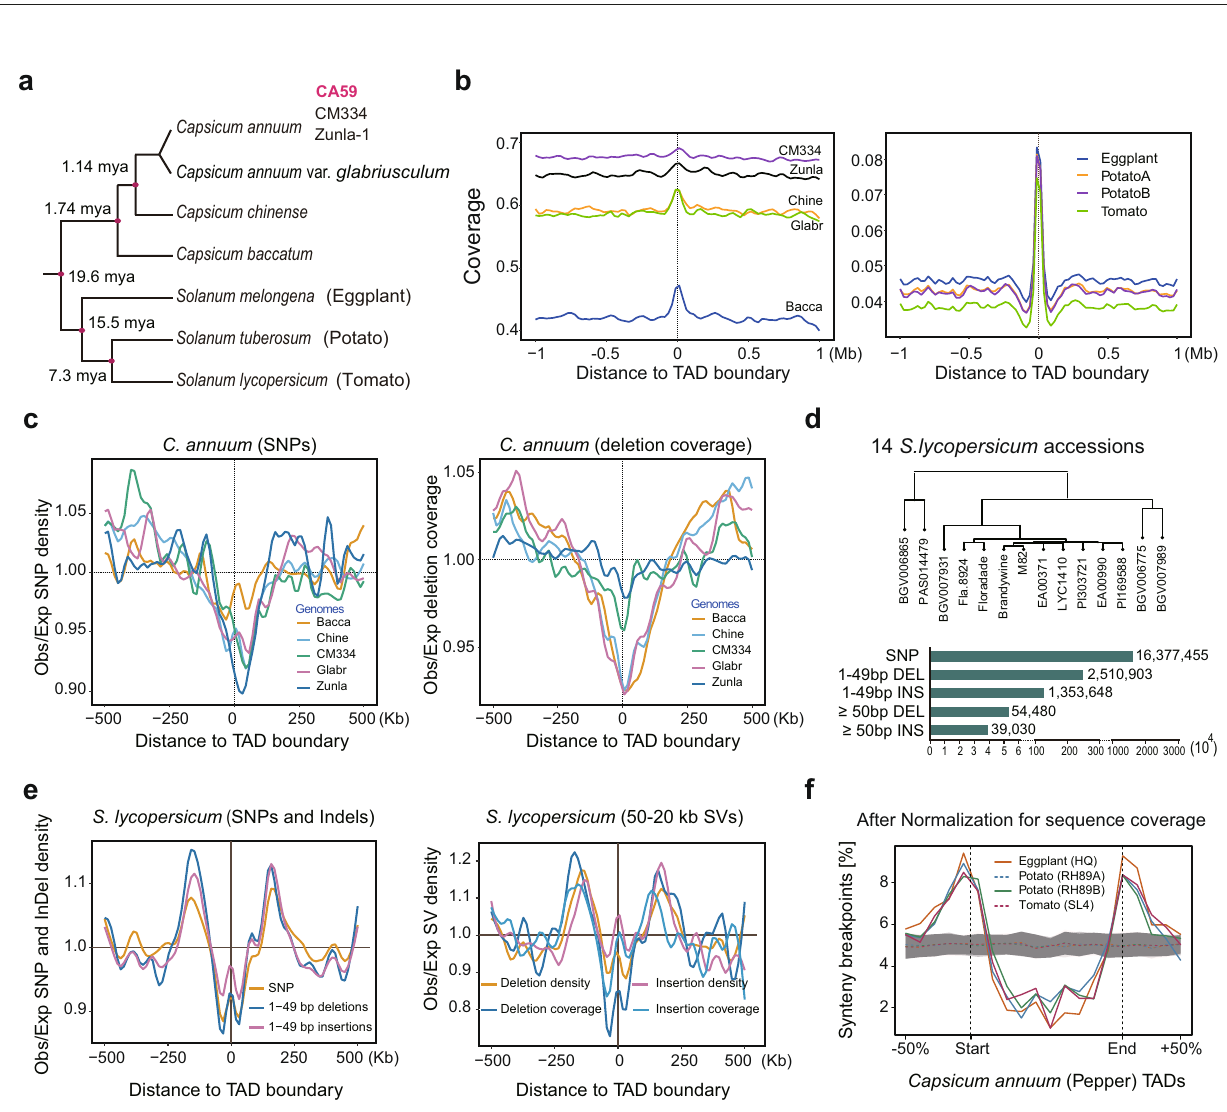
Fig. 5 Chromatin folding domains are frequently demarcated by gene-to-gene loops. a Chromatin loops identi fi ed across tissues with Hi-C maps at multiple resolutions (e.g., 10, 15, 20, and 25 kb) by hicDetectLoops. Boxplot shows the median with (the fi rst and third) quartiles. Red dots indicate the mean values of loop size. b Numbers of tissue-speci fi c and shared loops. For each tissue, a shared loop was identi fi ed if it was present in any other tissues. A merged loop set was constructed by removing the redundant calls across all four tissues. c Example showing a genomic region (Chr09: 68,000,000 – 72,000,000) where chromatin loops demarcate TAD-like domains. Subcompartments and TADs identi fi ed at both 10-kb and 40-kb resolution for this region were shown above and right. Loops were shown as red dots in the Hi-C contact maps at 40 kb resolution (leaf). d Enrichment of contact frequency was observed at the corners of TAD-like domains of different sizes; that is, the peak loci are located at domain boundaries. More examples can be found in Supplementary Fig. 15d. e Representative example of loop anchors overlapping with genes. More examples can be found in Supplementary Fig. 15e. f Schematic representation of hypothesized gene-to-gene chromatin loops that mediate the formation of heterochromatin folding domains and spatial gene clusters. Source Data underlying Fig. 5a, b are provided as a Source Data fi le.